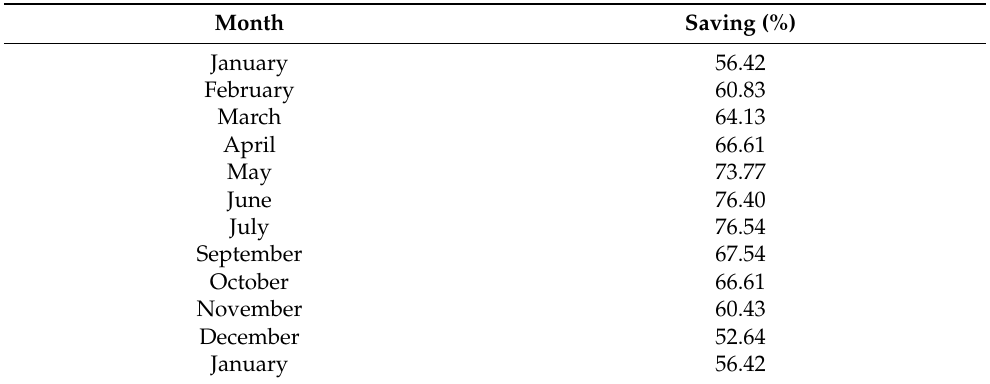
Figure 19. Histogram of average lighting levels inside the classroom with heliostatic illuminators during their time of use for teaching purposes in the months of ( a ) February; ( b ) April; and ( c ) June. Table 2. Savings in estimated monthly energy consumption in the classroom as a result of the installation of heliostatic